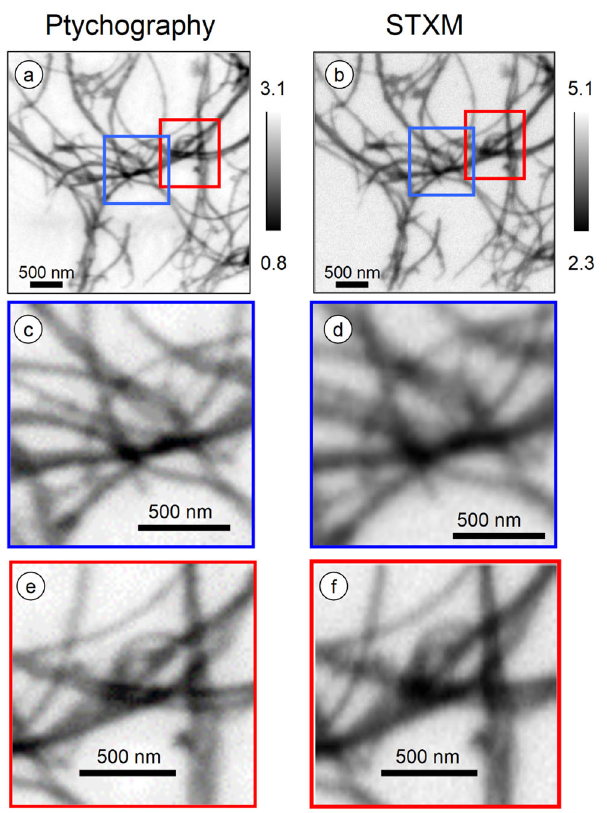
Fig. 3 Comparison of CNT imaging by defocusing ptychography and high- resolution STXM. a Ptychography amplitude image of the CNT sample measured at 285.2 eV using a 1.0 μ m defocused probe. The intensity limits are arbitrary units. b STXM transmission image of the same area measured with a zone plate having a 25 nm outer zone width. The intensity limits are count rate in MHz. c , e Ptychography image details from the blue and red boxes indicated in ( a ). d , f STXM image details of the blue and red areas indicated in ( b ). (see Supplementary Table 1 for acquisition